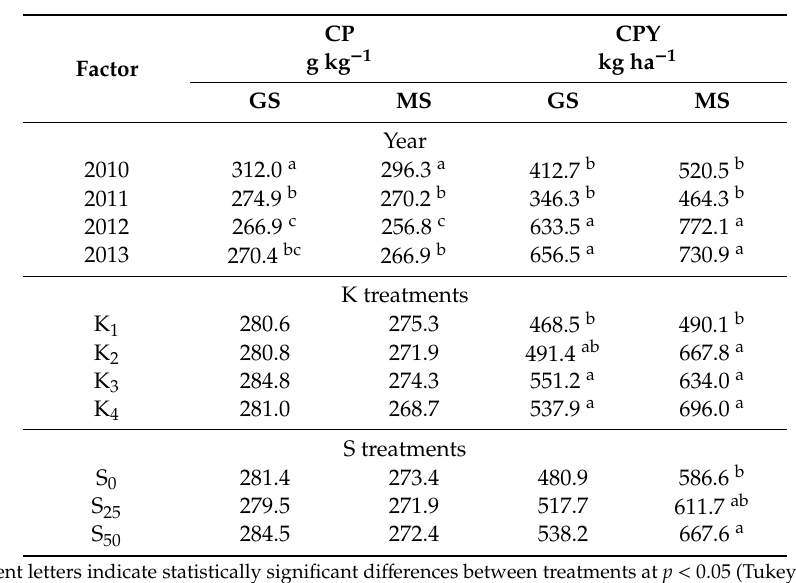
Table 3. E ff ect of growing season, K treatment, and S application on crude protein content (CP) and crude protein yield (CPY) depending on seed maturity. GS, immature seeds; MS, mature seeds.